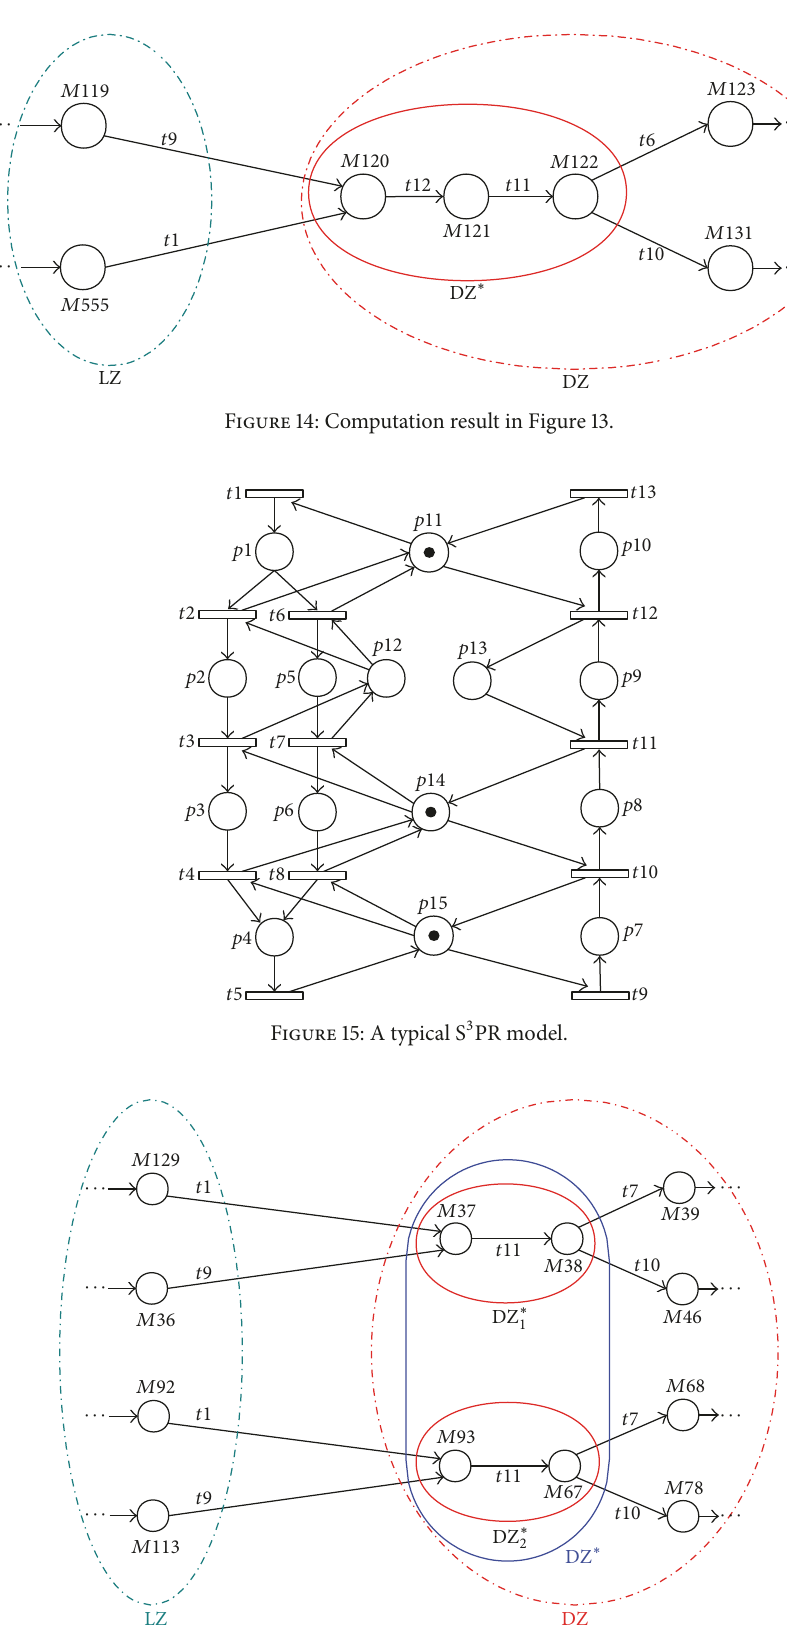
Figure 16: Simulation result of the net in Figure